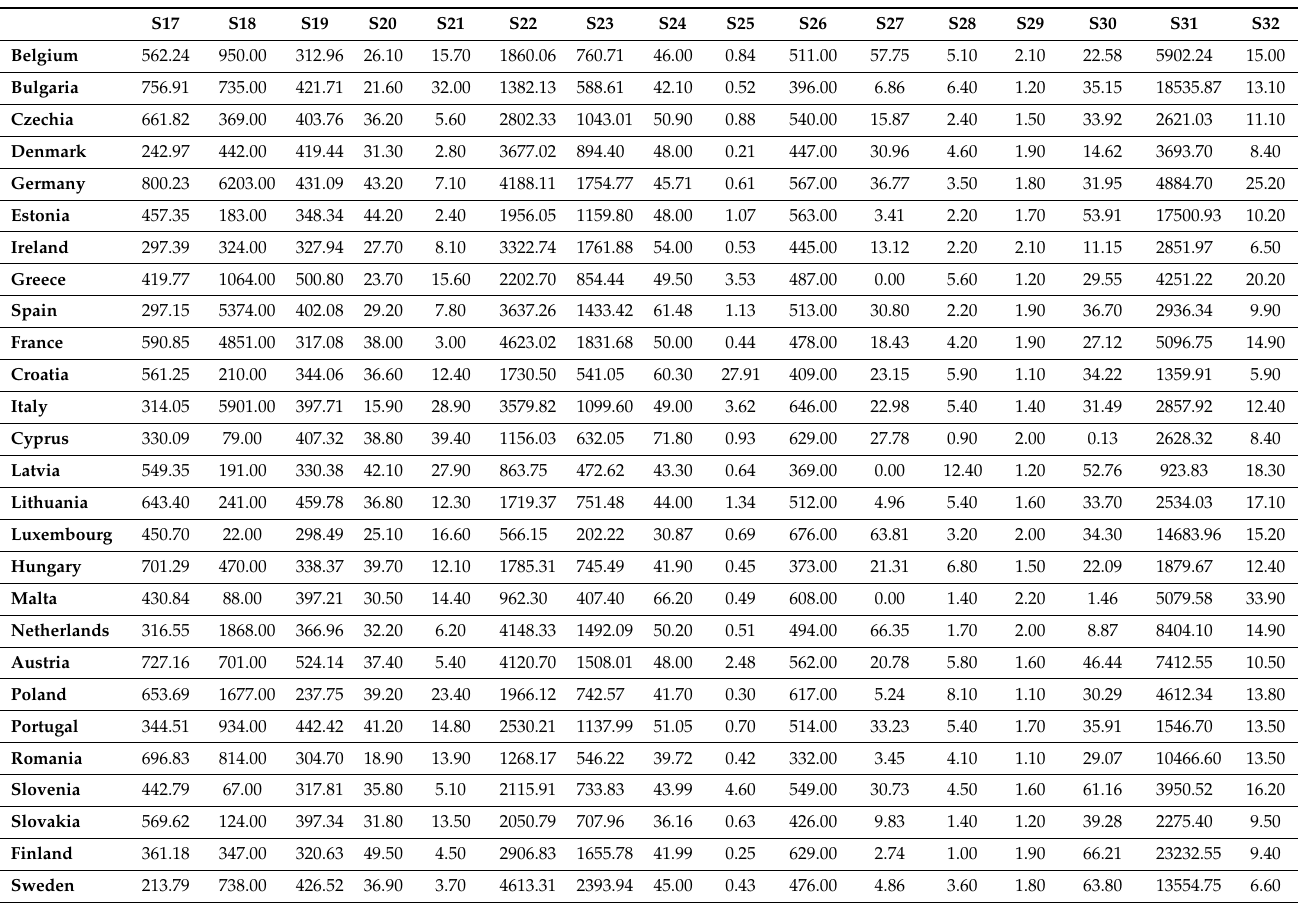
Table A2. Data on the standard of living—part 2.